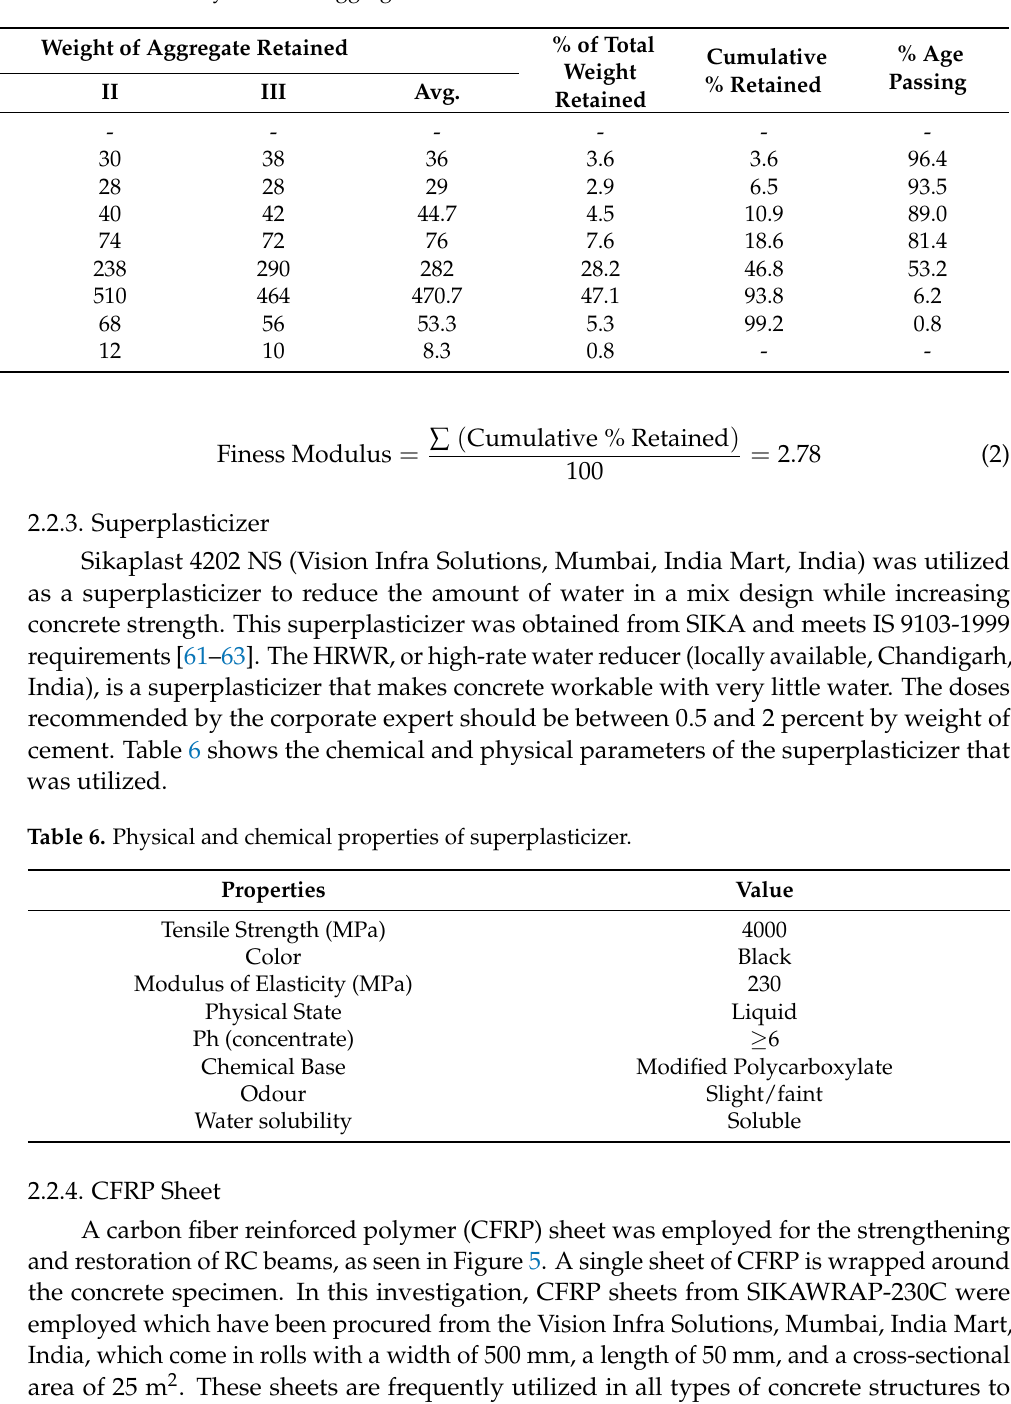
Table 5. Sieve analysis of fine aggregate.